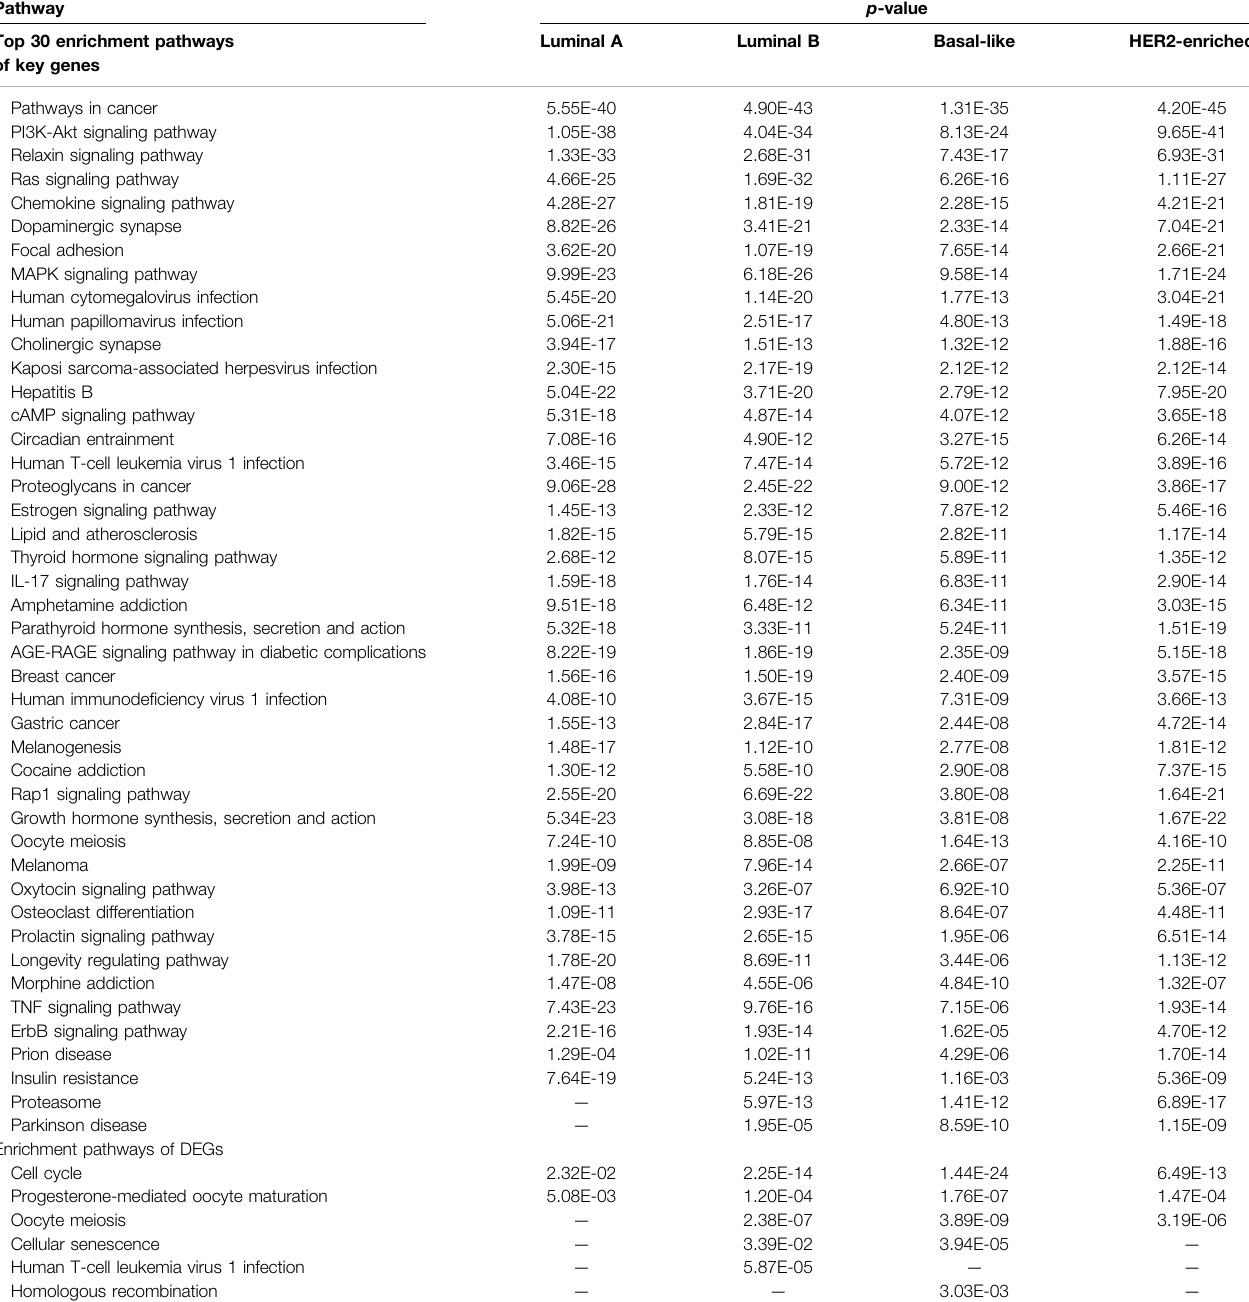
TABLE 3 | Top 30 enrichment pathways of key genes and enrichment pathways of